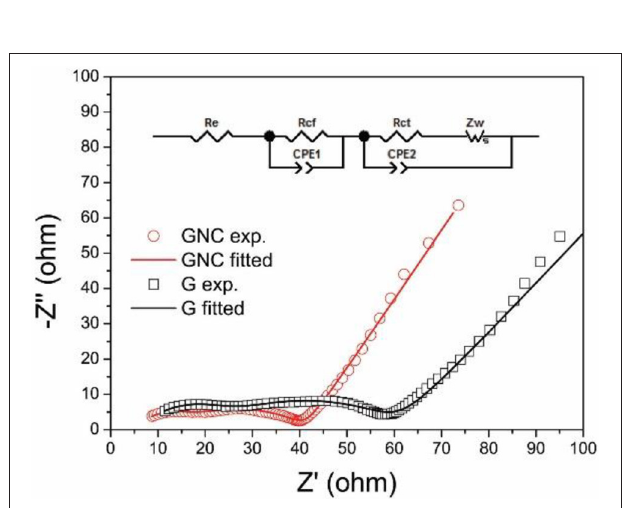
FIGURE 6 | The Nyquist plots of the half cells made from G and GNC.